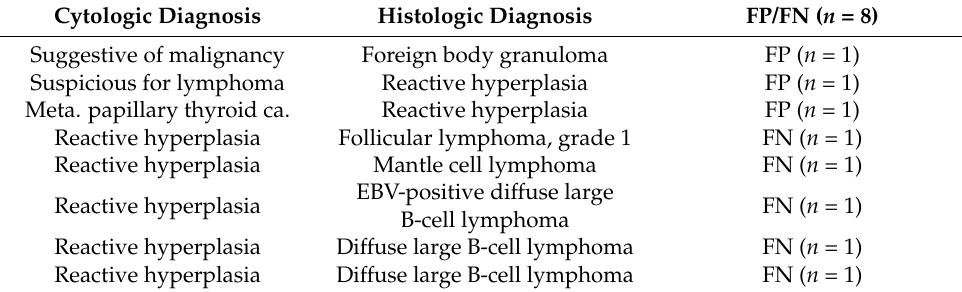
Table 6. False positive and false negative results of lymph node FNAC.